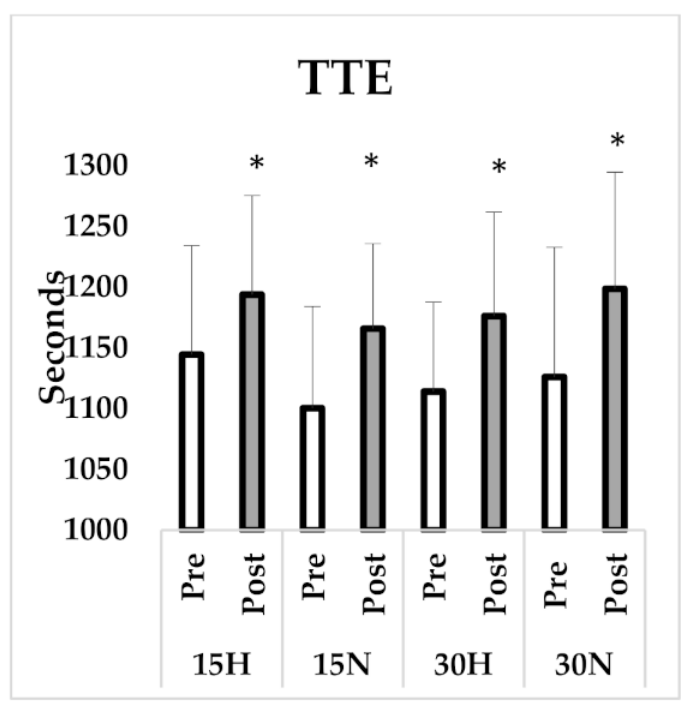
Figure 3. Time before exhaustion in VO 2max test. *: significant difference between pre and post